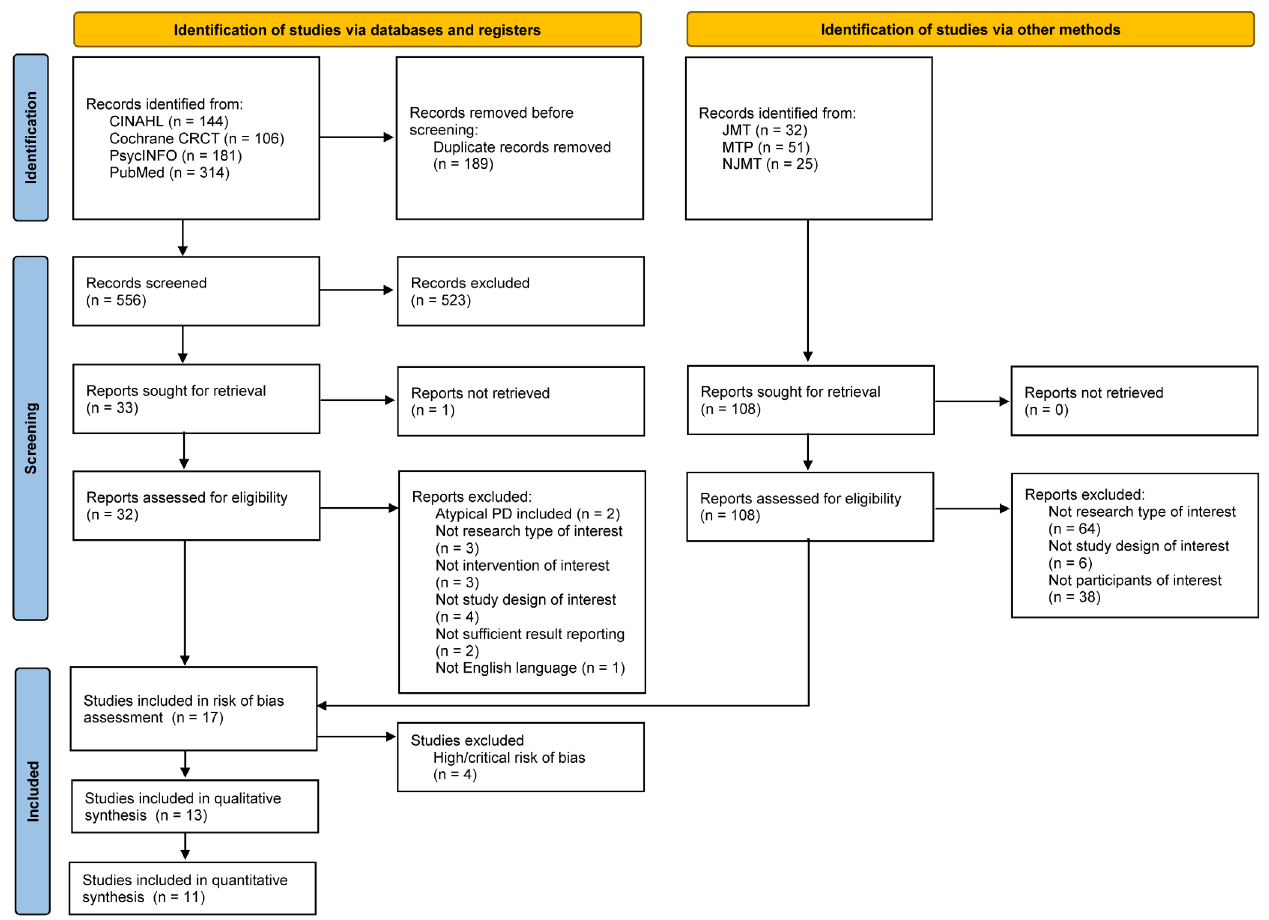
Figure 1. Flow diagram of the study selection process according to the preferred reporting items for systematic reviews and meta-analyses (PRISMA) 2020 Guideline.